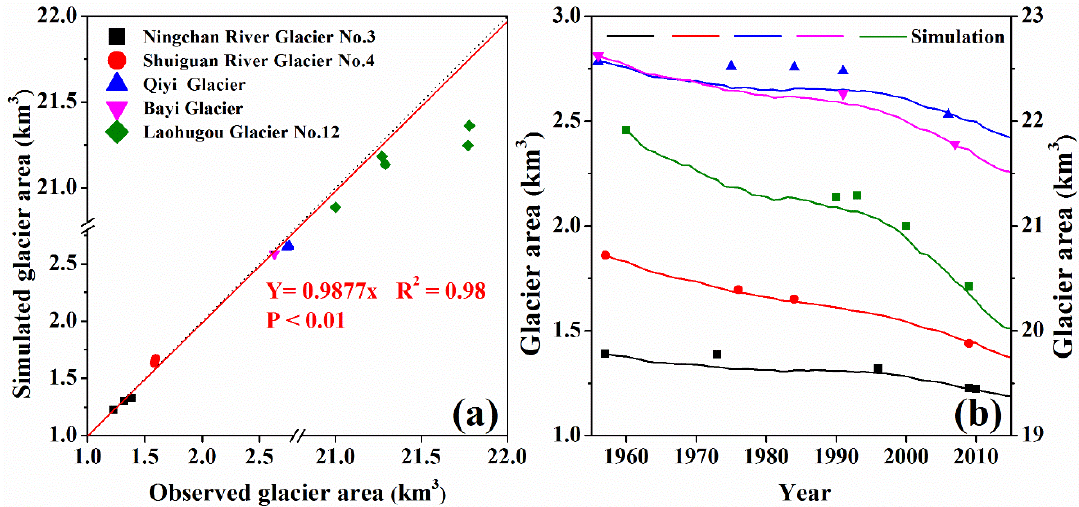
Figure 4. Validation of modelled glacier area. The observed glacier area includes 5 glaciers randomly selected in the QLM. In figure ( a , b ), the geometrical symbol represents the intermittently observed glacier area. In figure ( b ), the line represents a simulated trajectory of glacier area change. Among them, the Laohugou Glacier No.12 is referenced to the right axis.